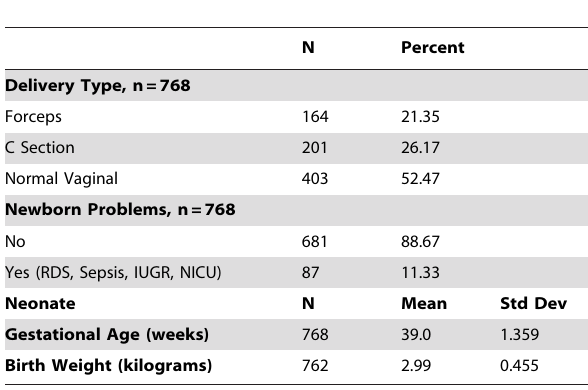
Table 3. Comparison of NAAT test with rapid diagnostic test. Table 4. Neonate